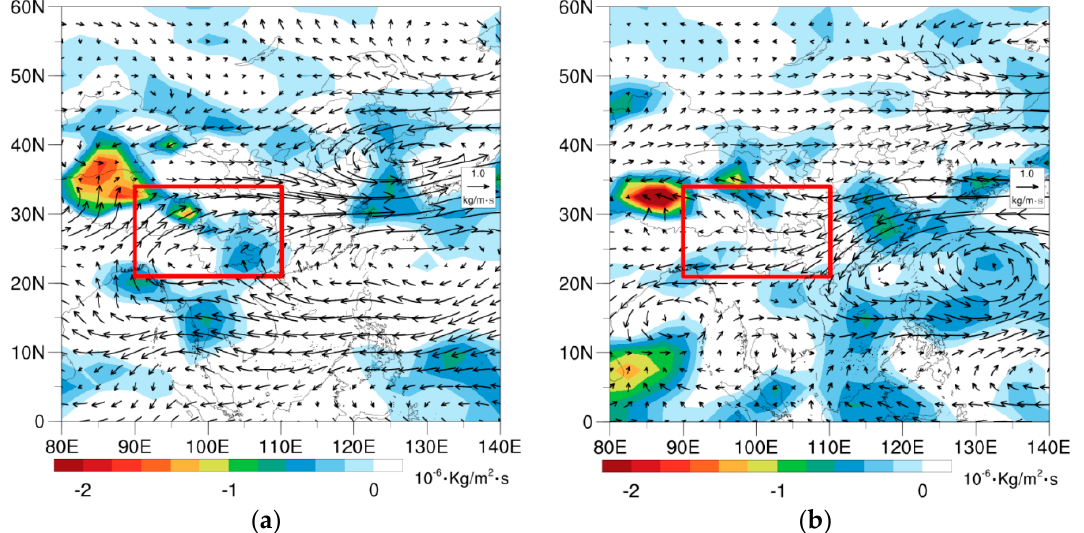
Figure 16. Whole-layer water vapor flux integral and its divergence anomaly in summer of strong and weak